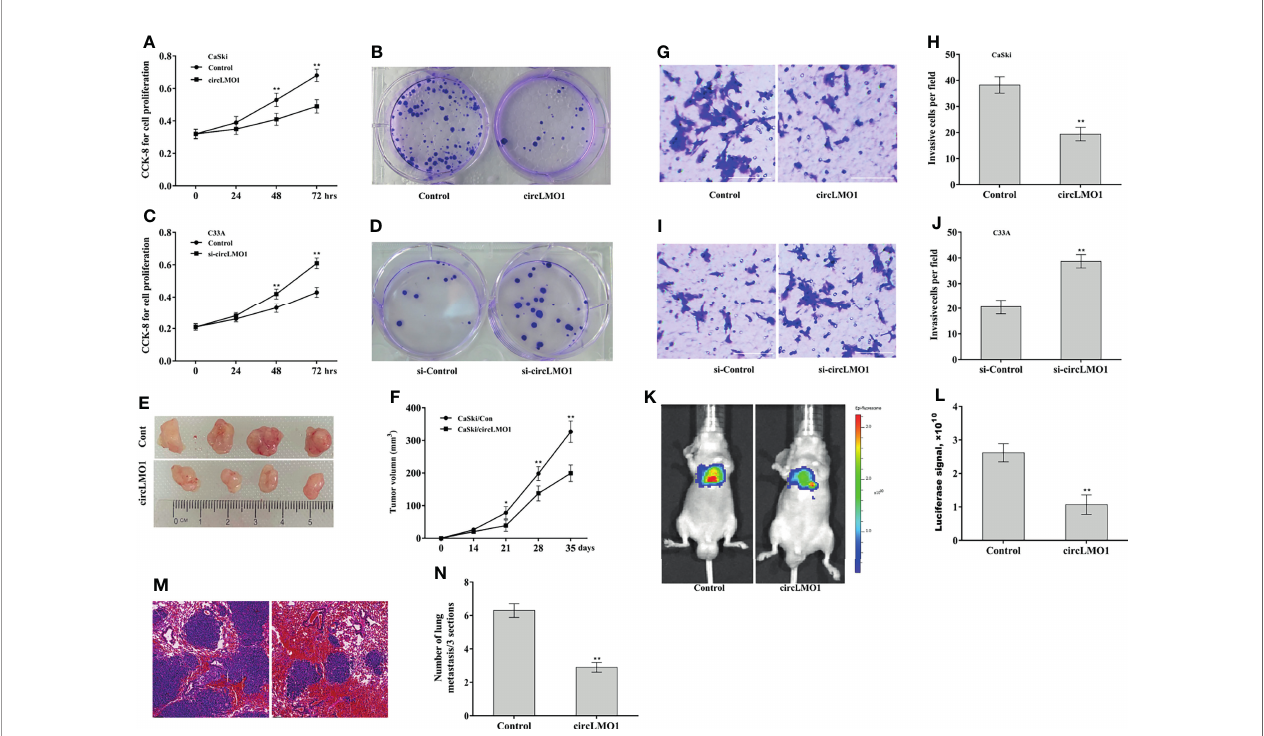
FIGURE 3 | CircLMO1 inhibits cervical cancer growth and metastasis. CCK-8 (A) and colony formation assay (B) were carried out to assess CaSki cell proliferation and growth after circLMO1 overexpression. CCK-8 (C) and colony formation assay (D) were carried out to assess C33A cell proliferation and growth after circLMO1 knockdown. (E, F) CaSki cells stably overexpressed with circLMO1 were injected subcutaneously into nude mice, and tumor volume was calculated at different time points (n = 4). Transwell invasion assay of CaSki cells (G, H) after circLMO1 overexpression and C33A cells (I, J) after circLMO1 knockdown. Scale bar = 100 µm. (K, L) CaSki cells stably overexpressed circLMO1 were injected into nude mice through tail vein, and in vivo bioluminescence imaging was used to assess cancer metastasis at 10 weeks (n = 4). (M) H&E staining in lung tissue was used to assess lung metastasis. Scale bar = 100 µm. (N) The number of lung metastatic nodules at 10 weeks. *p < 0.05, **p <